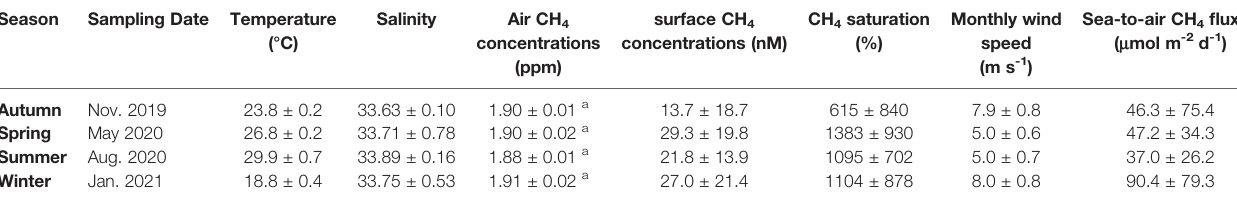
TABLE 2 | The seasonal average surface hydrographic data, CH 4 concentrations, air CH 4 concentrations, wind speed and sea-to-air CH 4 fl